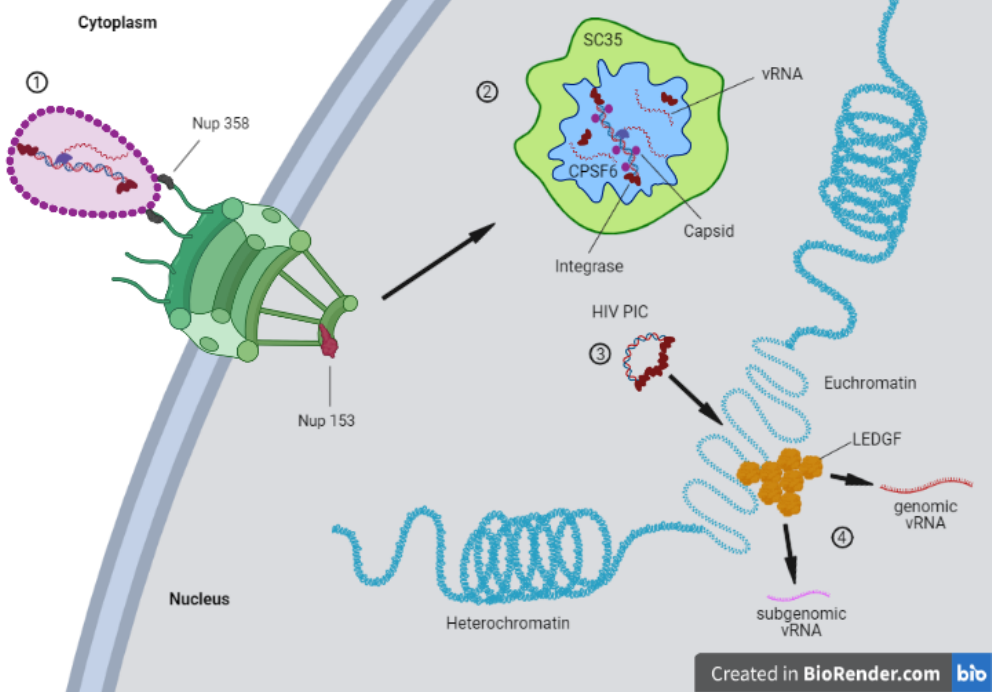
Figure 3. The HIV-1 core carrying the viral genome docks at the NPC followed by nuclear translocation (1). The nuclear RT takes place in HIV-1 MLOs formed by nuclear speckles factors and CPSF6 (2). These are maturation sites of the pre- integration complex (PIC), which once formed is released from them to join euchromatin regions containing LEDGF clusters (3). These are proviral sites where the viral genome is transcribed in genomic and subgenomic viral RNAs (4). Created with BioRender.com accessed on 7 June 2021